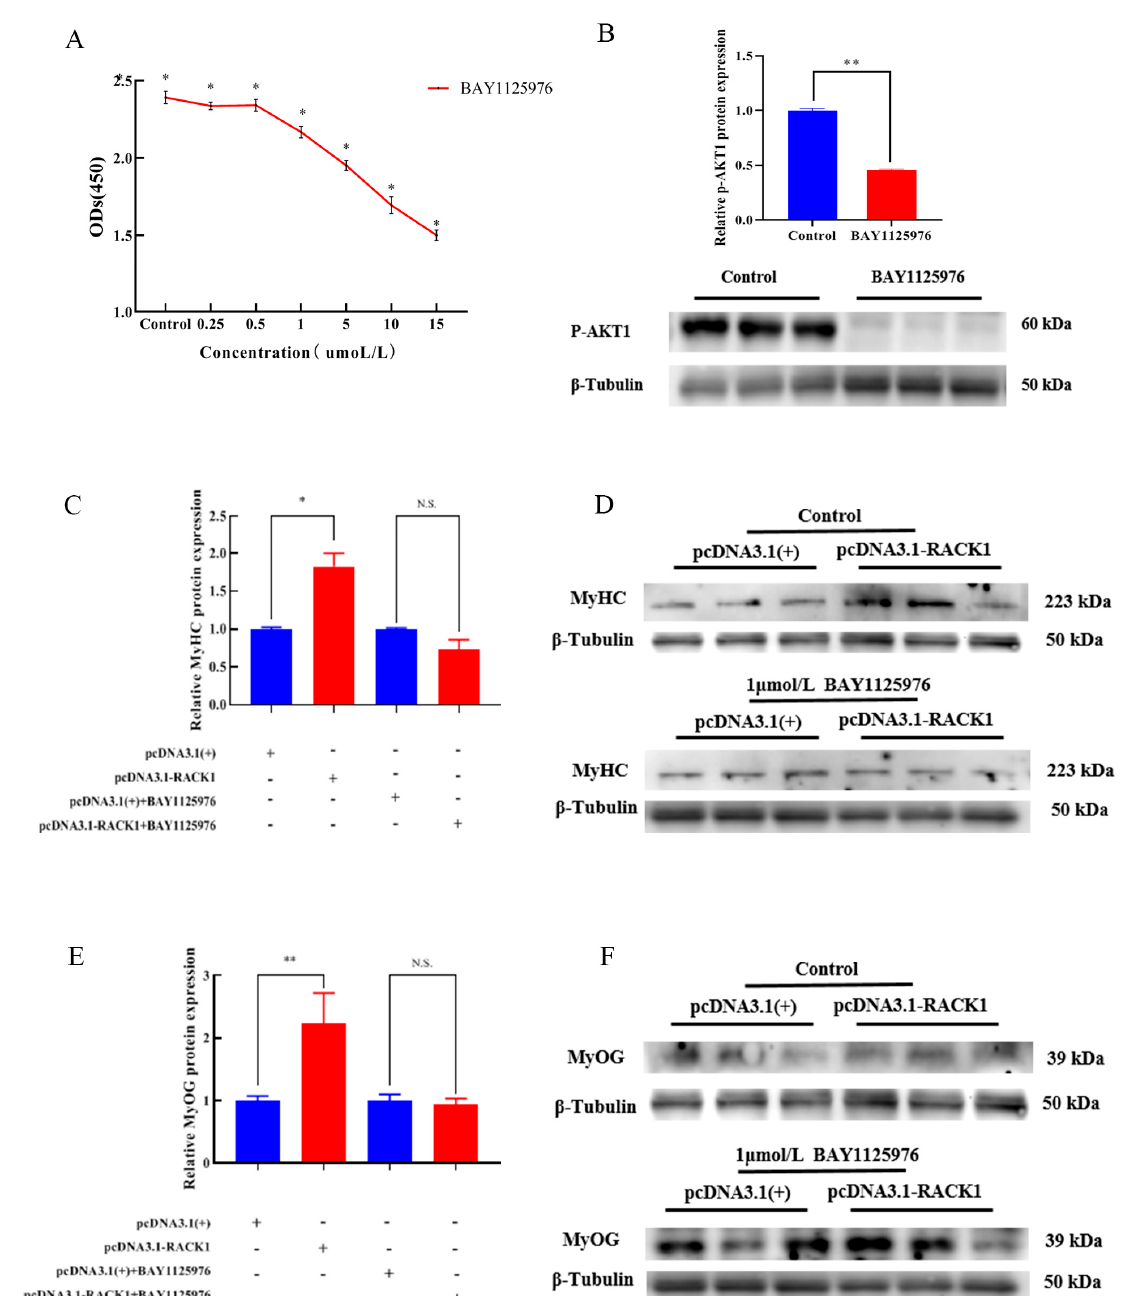
Figure 8. Inhibition of the PI3K/AKT/mTOR pathway affects myogenic differentiation after overex- pression of RACK1. ( A ) CCK-8 assay to screen the concentration of BAY1125976. ( B ) Evidence of the inhibitory effect of BAY1125976 on AKT1 protein level. ( C , E ) Results of quantification of protein gray value analysis. ( D , F ) Representative bands of MyHC and MyOG after overexpression of RACK1. Differences between groups were statistically analyzed using Student’s t -test. p < 0.05 was considered statistically significant (* p < 0.05 and ** p < 0.01). And N.S., not significant ( p > 0.05).